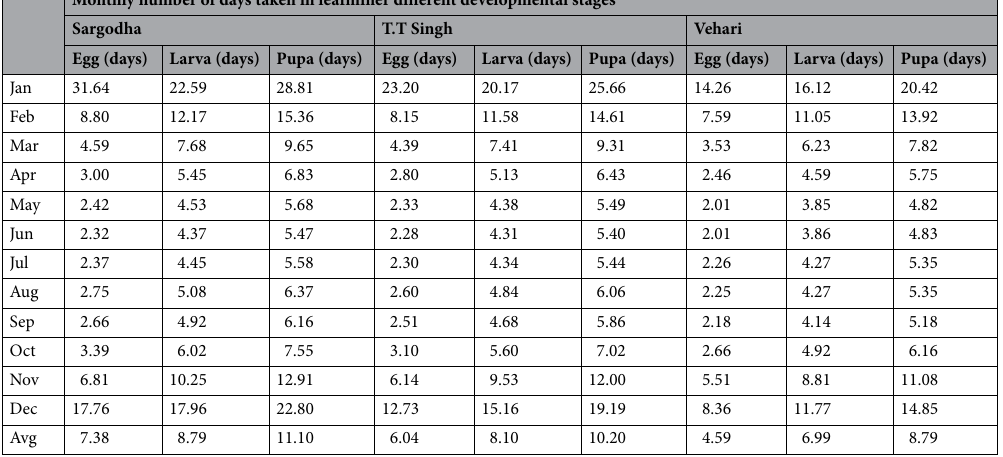
Table 4. Leafminer developmental stages time taken in days.